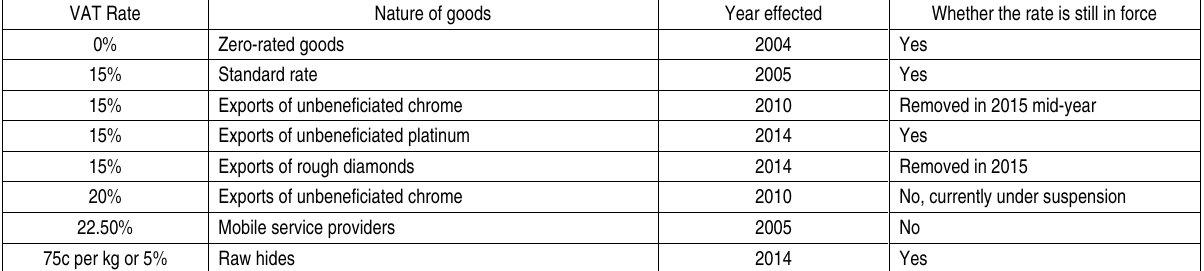
Table 4. Standard VAT rates and VAT on exports in